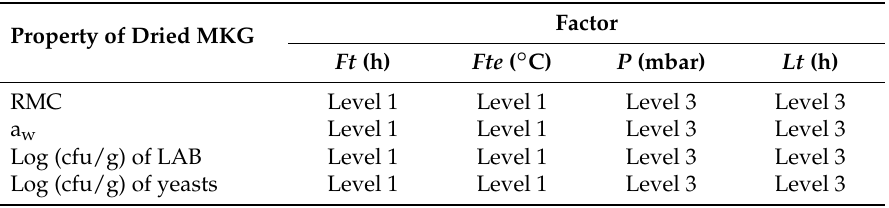
Table 9. Optimal factors for each properties of dried